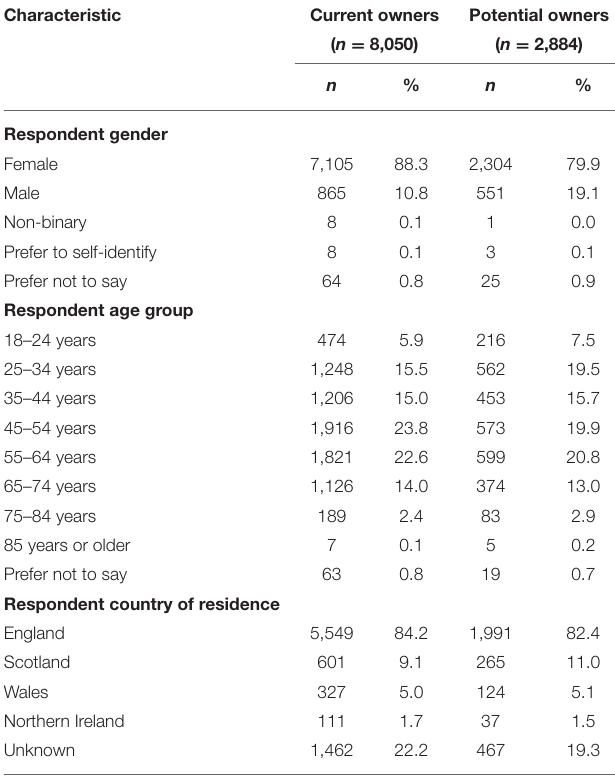
TABLE 1 | Demographic characteristics of survey